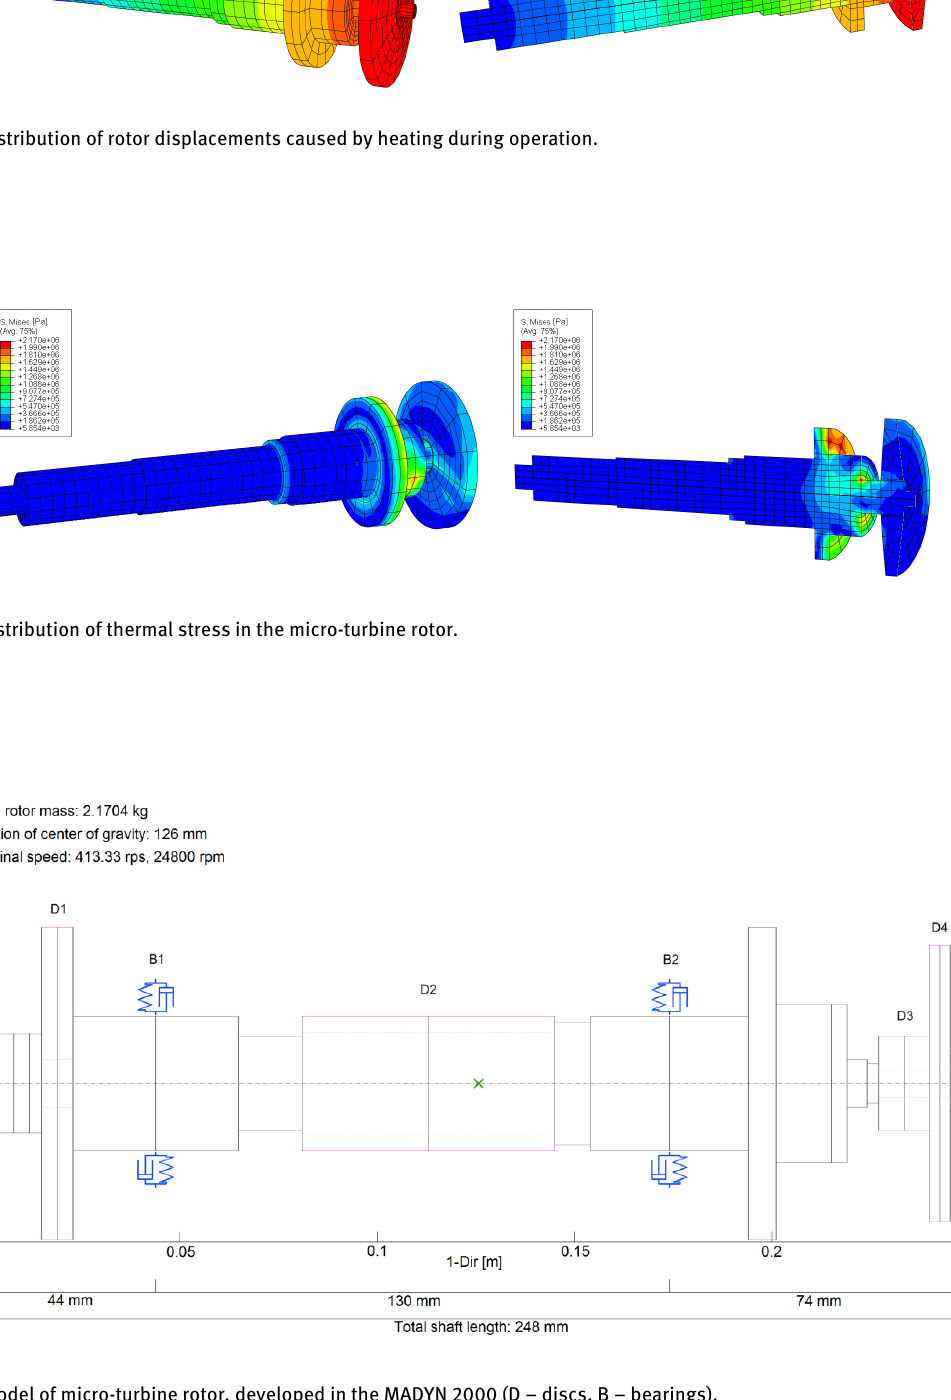
Figure 6: The model of micro-turbine rotor, developed in the MADYN 2000 (D – discs, B –